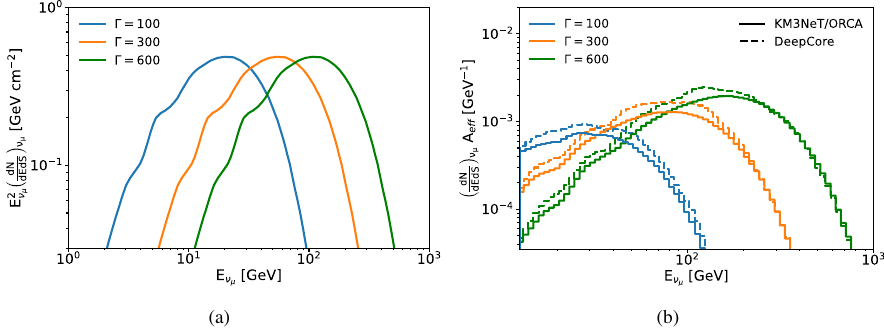
Figure 1: (a) The ν µ + ¯ ν µ energy fluence for a GRB with observed γ -ray fluence F γ for Γ= 100 (cyan), Γ= 300 (orange) and Γ= 600 (green). (b) Number of signal events per unit energy in GeV expected in KM3NeT / ORCA (solid lines) and DeepCore (dotted lines) for the neutrino energy fluences shown in